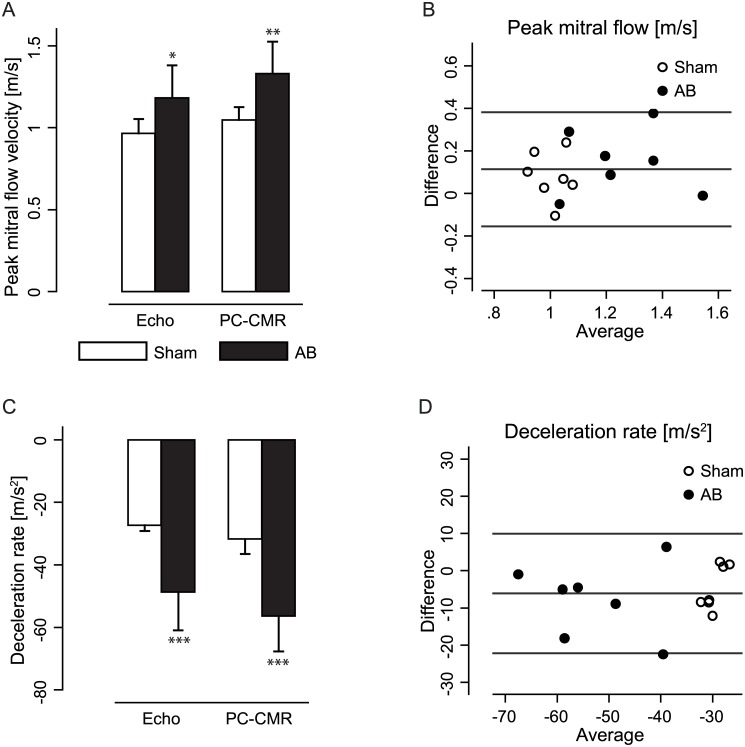
Peak mitral flow and deceleration rate in aortic banding (AB) and sham rats.(A) Peak mitral flow velocity in AB and sham operated rats, using both echocardiography (echo) and phase-contrast cardiovascular magnetic resonance (PC-CMR). (B) Bland-Altman plot describing the difference between echo and PC-CMR in measuring peak mitral flow. (C) Mitral flow deceleration rate in AB and sham rats using echo and PC-CMR. (D) Bland-Altman plot describing the difference between echo and PC-CMR in measuring mitral flow deceleration rate. Values are presented as mean ± standard deviation. * indicate p<0.05, ** indicate p<0.01, *** indicate p<0.001 compared to sham within the corresponding method.